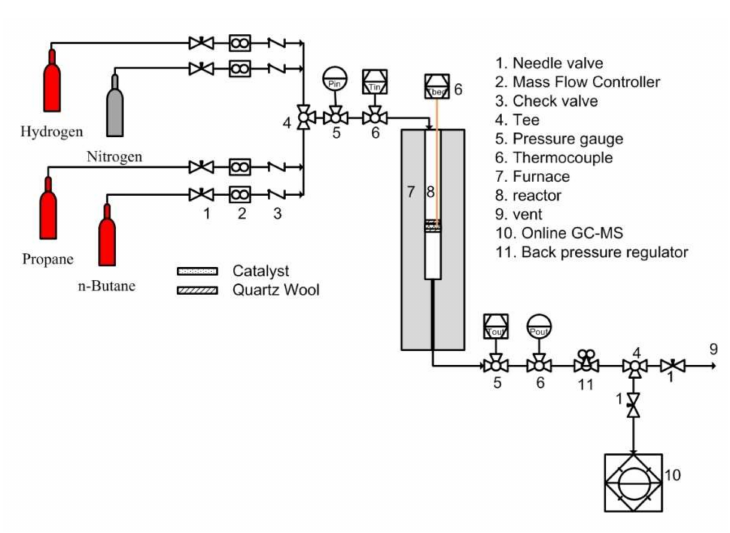
Figure 9. Process and instrumentation diagram (P&ID) of the experimental setup for mixed-para ffi n dehydrogenation